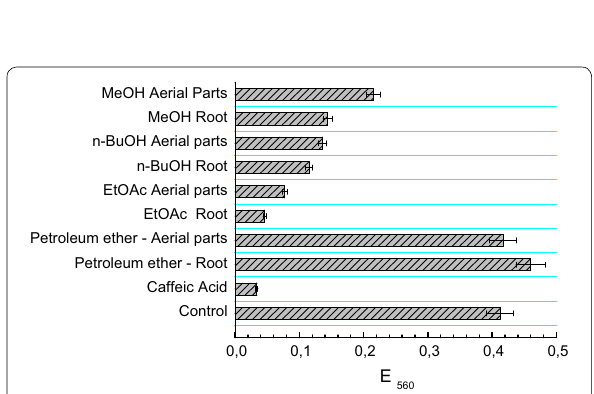
Fig. 3 Inhibitory effect of the plant extracts and fractions from Geum urbanum on the reduction of NBT by photochemically generated superoxide anion radicals